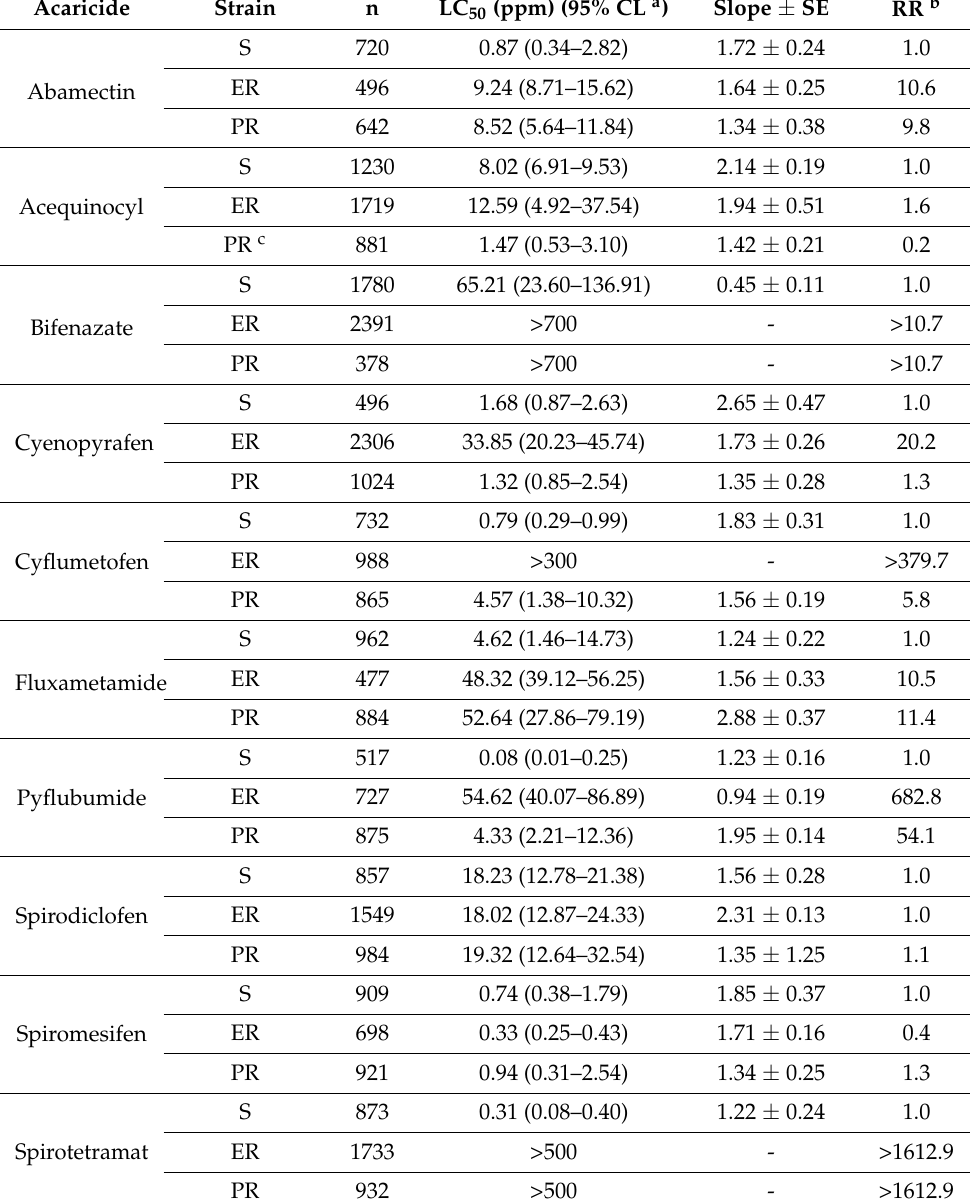
Table 4. Susceptibility to acaricides in the eggs of S, ER, and PR strains of T. urticae